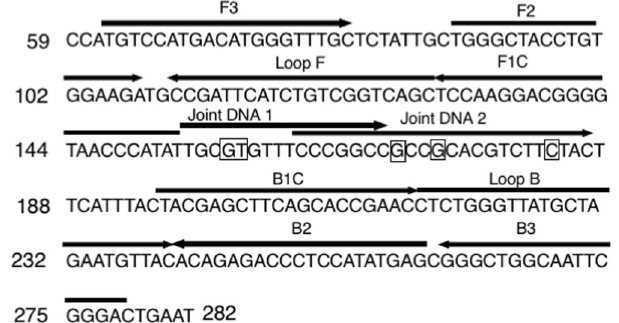
Figure 1. Design of LAMP primers and joint DNAs Partial SIX3 nucleotide sequences (positions 59 to 282) used for designing LAMP primers and joint DNAs. Positions of the designed primers and joint DNAs are indicated by arrows. Point mutation sites are shown by an open